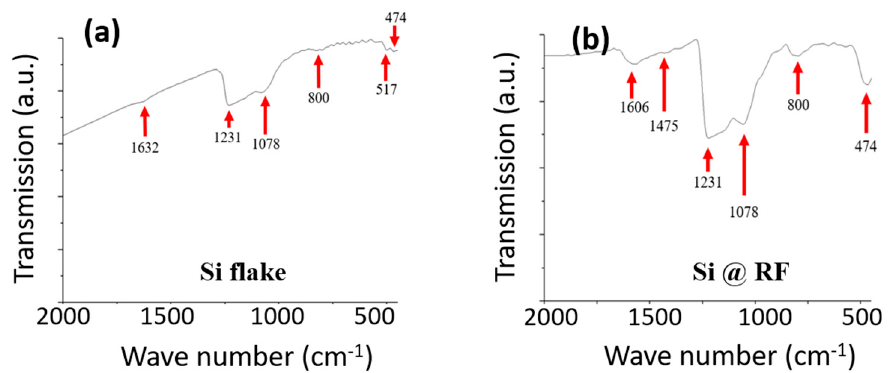
Figure 5. FTIR spectra of ( a ) pristine silicon flakes and ( b ) pristine silicon flakes with RF carbon coatings.